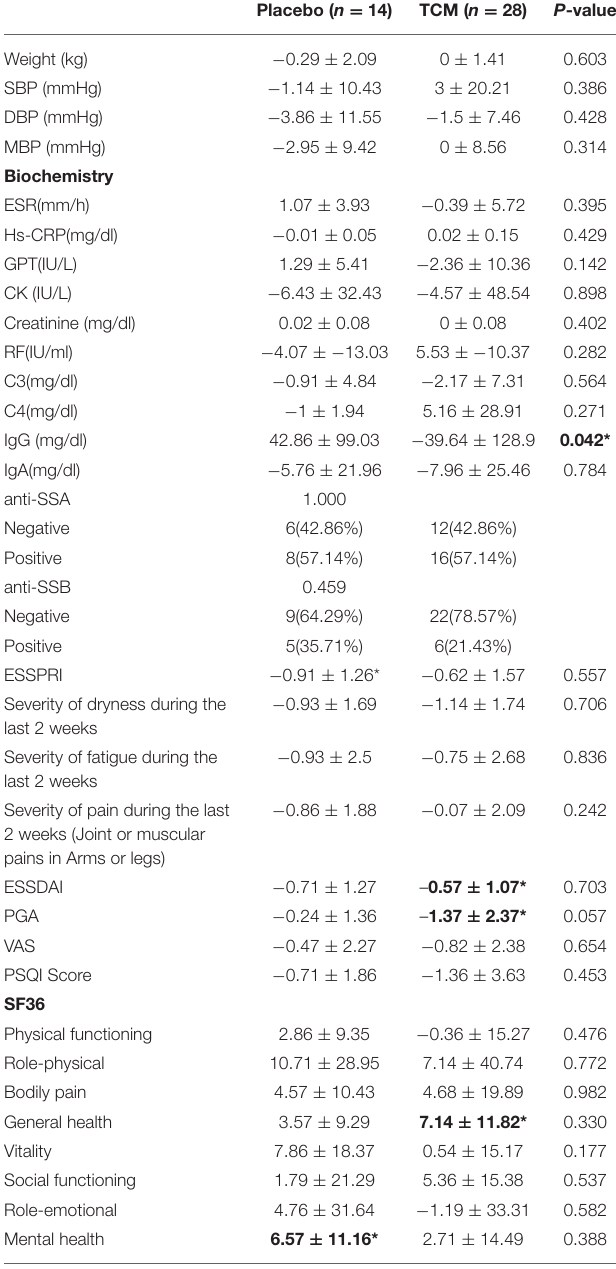
TABLE 2 | Changes in primary and secondary endpoints at week